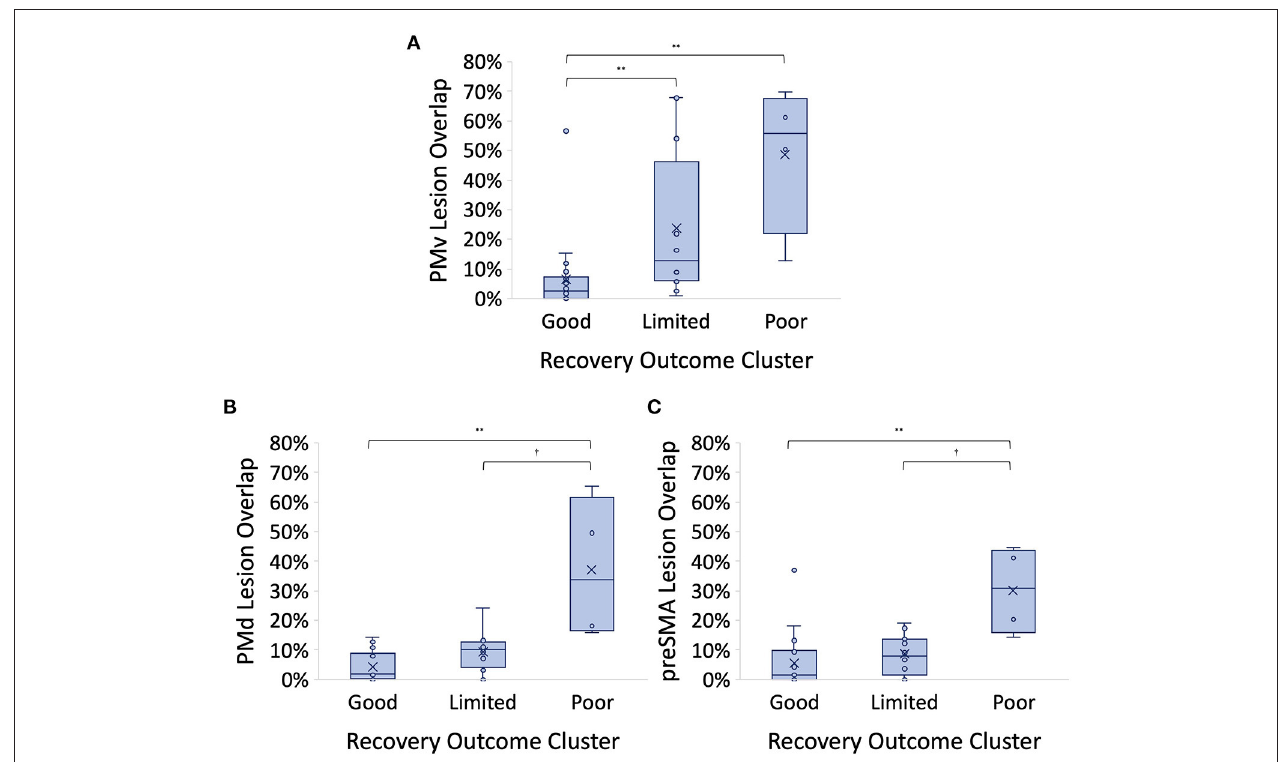
FIGURE 3 | (A) Ventral premotor (PMv) corticospinal tract (CST) lesion overlap % is higher for those in the Good outcome group over those in both the Limited and Poor outcome groups. Good-Limited p = 0.018, Good-Poor p = 0.005. (B) Dorsal premotor (PMd) CST lesion overlap % is higher for those in the Good outcome group over those in the Poor outcome group and showed a non-significant trend for a difference between Limited and Poor outcome groups. Good-Poor p = 0.002, Limited-Poor p = 0.073. (C) Pre-supplementary motor (preSMA) CST lesion overlap % is higher for those in the Good outcome group over those in the Poor outcome group and showed a non-significant trend for a difference between Limited and Poor outcome groups. Good-Poor p = 0.004, Limited-Poor p = 0.084. All p values reported represent adjusted significance; Cluster centers denoted with “x” in the figure; horizontal bars represent medians * p < 0.05 level, ** p < 0.01 level; † Approaching significance after Bonferroni